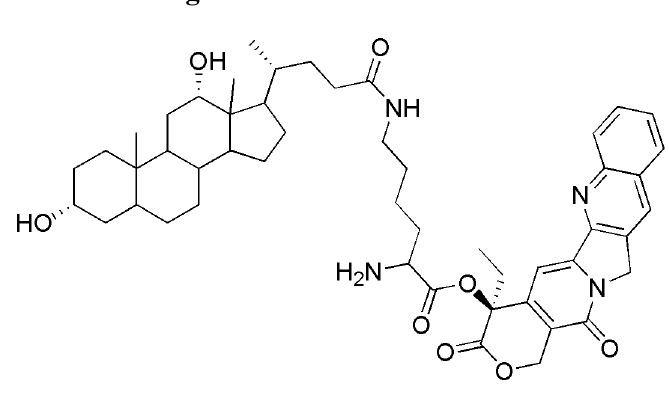
Figure 1. The structure of